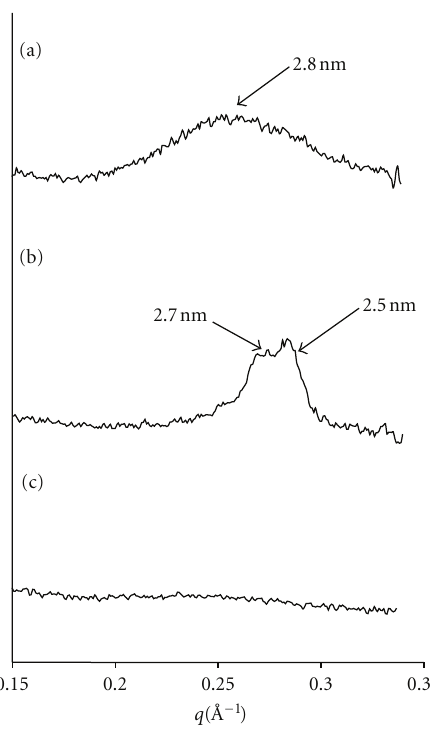
Figure 8: WAXS profiles of (a) PMAPOSS- b -PMAHFC 1 , (b) PMAPOSS- b -PMAHFC 2 , and (c) PMAPOSS- b -PMAHFC 3